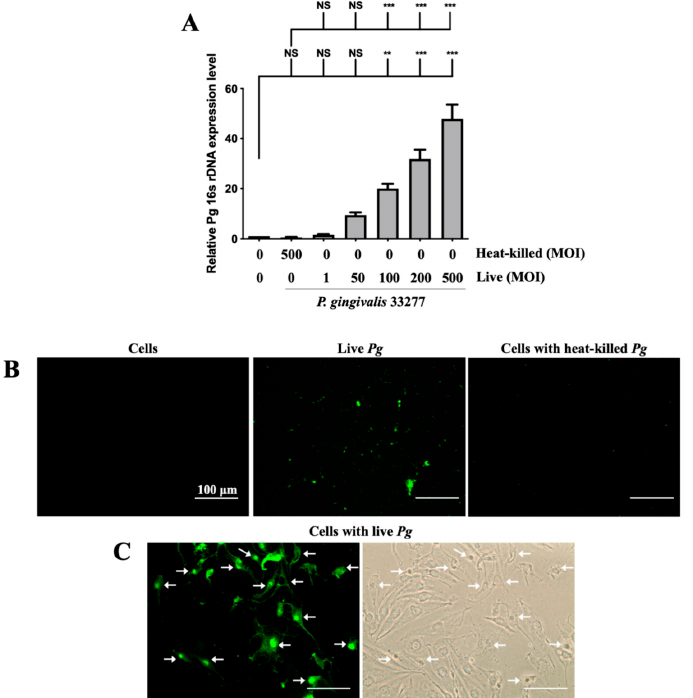
Figure 1. Expression of P. gingivalis in brain endothelial cells after bacteria infection. P. gingivalis and heat-killed bacteria are pre-labeled with FITC before cell infection. bEnd.3 cells are infected with various MOIs (1, 50, 100, 200 or 500) of P. gingivalis or P. gingivalis for 90 min, and the expression of P. gingivalis is quantitated by qPCR assay with bacterial 16S rDNA ( A ). bEnd.3 cells alone, FITC- labeled live P. gingivalis alone, and FITC-labeled heat-killed P. gingivalis with cells are observed us- ing a fluorescence microscope ( B ). FITC-labeled P. gingivalis cells after bacterial infection are shown in ( C ). Arrows show invasion and attachment of FITC-labeled P. gingivalis to infected cells. Data are presented as the mean ± SEM ( n = 4). **, p < 0.01; ***, p < 0.001; NS, p > 0.05 indicate a significant difference compared to the heat-killed P. gingivalis and control groups. The scale bar represents 100 μ m ( B ).